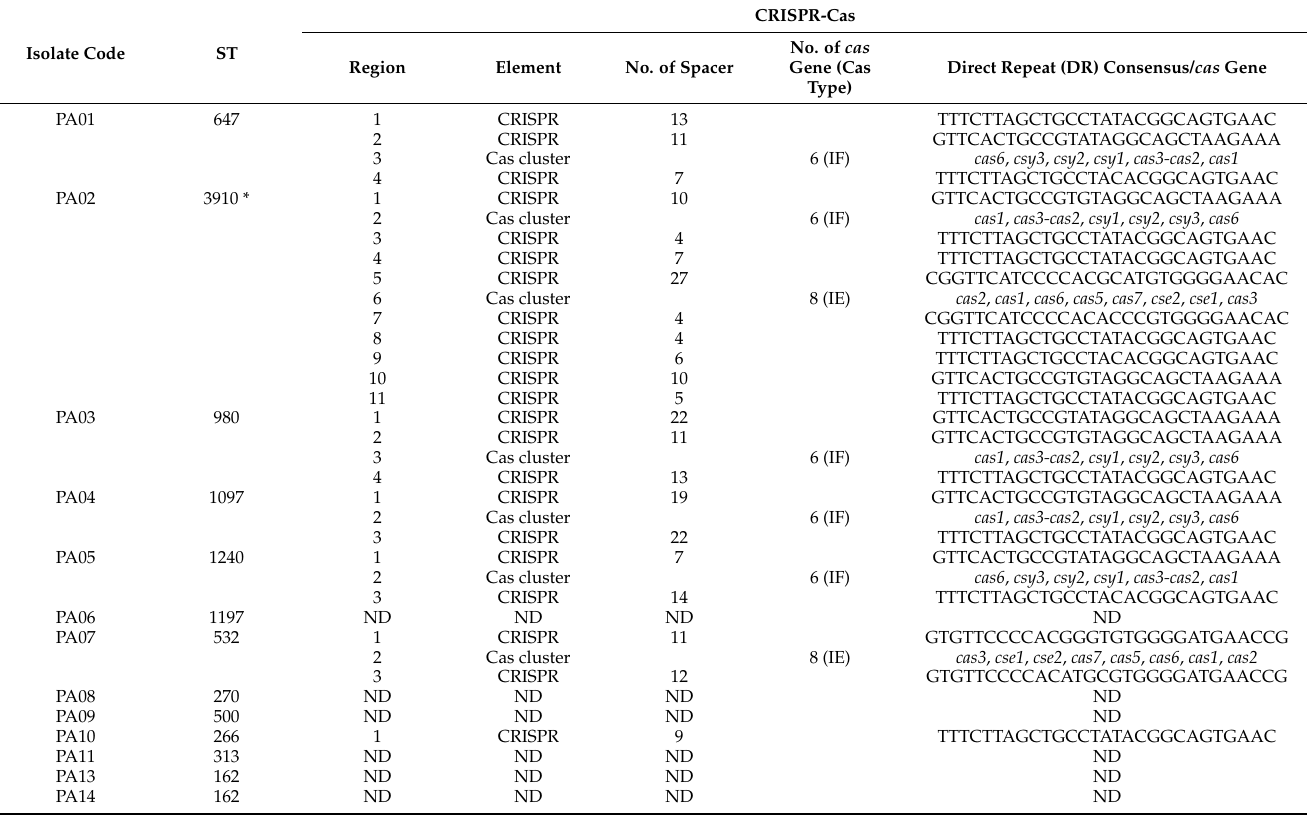
Table 3. Clustered regularly interspaced short palindromic repeats and CRISPR-associated protein (CRISPR-Cas) system in the colonizing isolates of P. aeruginosa .